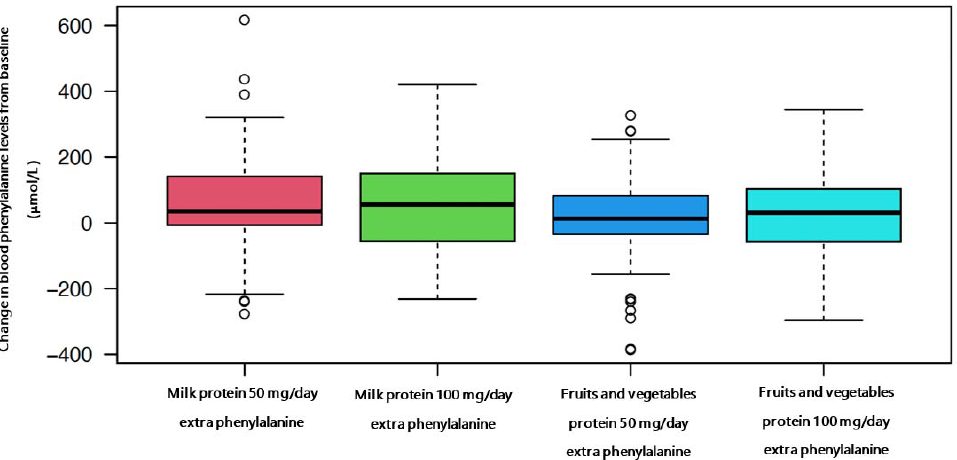
Figure 2. Mean change of blood phenylalanine from baseline in each intervention over 4 weeks. Mean blood phenylalanine (range) from baseline: 50 mg/day of phenylalanine from milk protein (35 μ mol/L; − 7142) n = 8; 100 mg/day of phenylalanine from milk protein (56 μ mol/L; − 56, 149) n = 5; 50 mg/day of phenylalanine from fruits and vegetables (13 μ mol/L; − 34, 79) n = 16; 100 mg/day of phe ‐ nylalanine from fruits and vegetables (30 μ mol/L; − 58, 103) n = 13.The circles represent outliers. Figure 3 represents changes in mean blood phenylalanine from baseline over each four ‐ week phase, and Figure 4 shows the changes over each week of the intervention pe ‐ riod. A higher and faster increase in blood phenylalanine is observed with milk protein